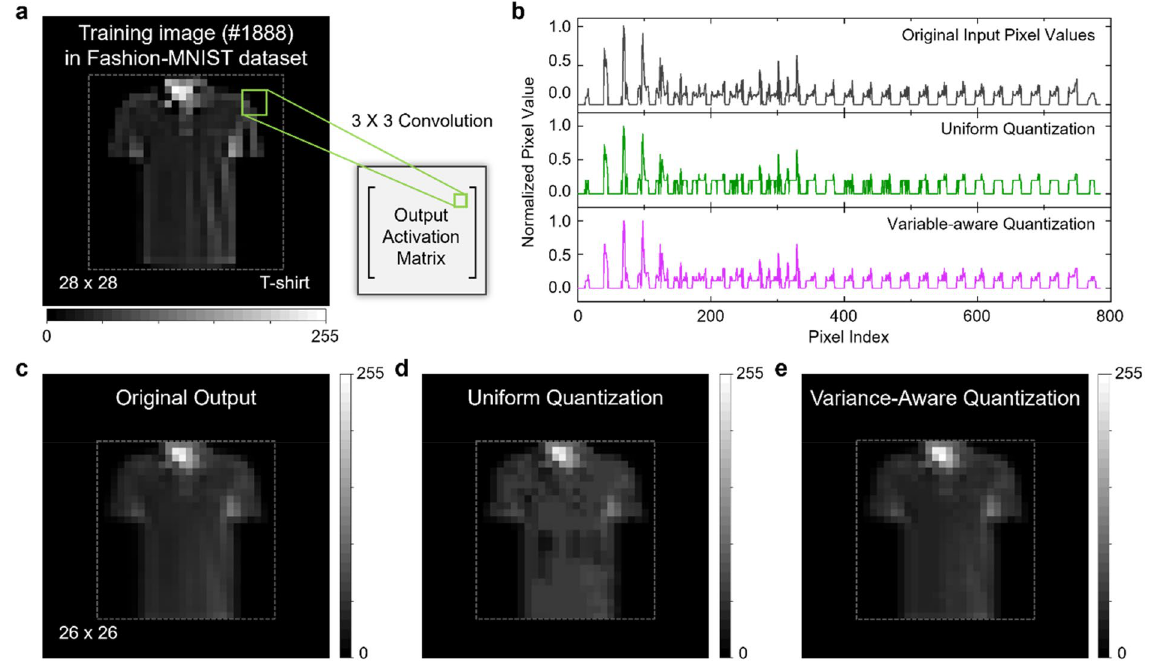
Figure 5. Variance-aware weight quantization for the convolution operation. ( a ) The training sample image (image #1888) of Fashion-MNIST dataset. The image consists of 28 × 28 gray-colored pixels. We apply a 3 × 3 convolution filter (stride of 1 × 1) to the input image and compare the output. ( b ) Normalized original input pixel values (top), the input pixel values quantized using the uniform states (middle), and the input pixel values quantized using the variance-aware states (bottom). ( c ) The original output of the convolution operations without quantization. ( d ) The output obtained by applying the uniform quantization. ( e ) The output obtained by applying the Figure 4d,e show the number of the correctly- and wrongly-quantized elements of the output activations using the uniform quantization and the VAQ, respectively. Note that the uniformly-configured states do not appro- priately represent the original data. Due to the strong overlap in the small-value regime, most of the quantized elements are assigned to the incorrect neighbor states. Even though this error rate is somewhat exaggerated due to the small number of available states (i.e., 12), it is clear that the quantization error is severe in this conventional quantization scheme. On the other hand, the VAQ method remarkably reduces the error. This comparison indi-